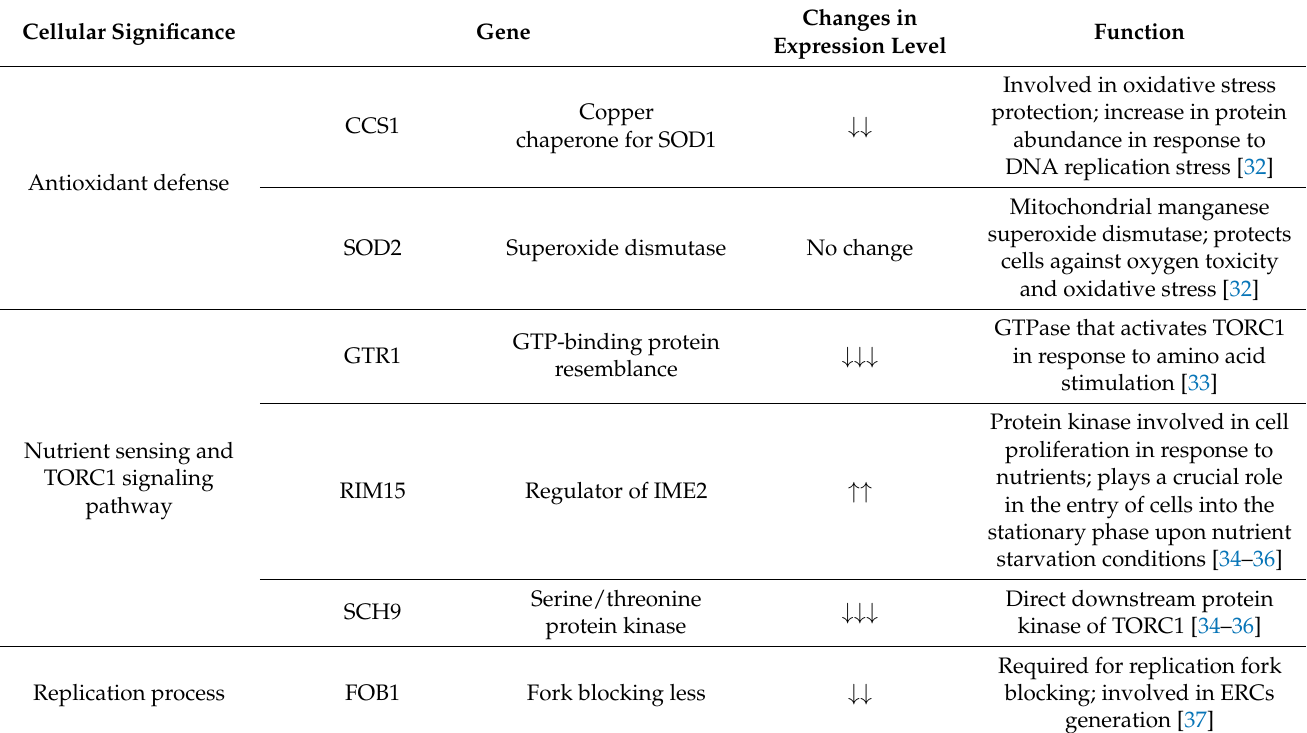
Table 3. List of genes analyzed using real-time PCR with the description of the function of their products. Upward arrow (upregulated expression); downward arrow (downregulated expression); the number of arrows correlates with the strength of expression